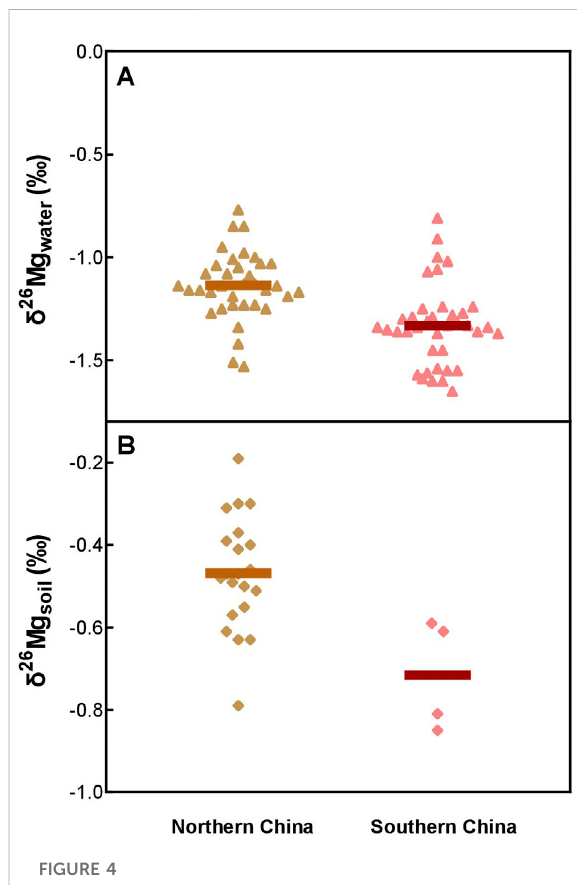
FIGURE 4 Mgisotopiccompositionsofsoils (A) andregionalwater (B) in northern and southern China. Data are from Fan et al., 2016; Gao et al., 2018; Tipper et al., 2006; Wimpenny et al., 2014; Xu et al., 2022. The horizontal bars are mean